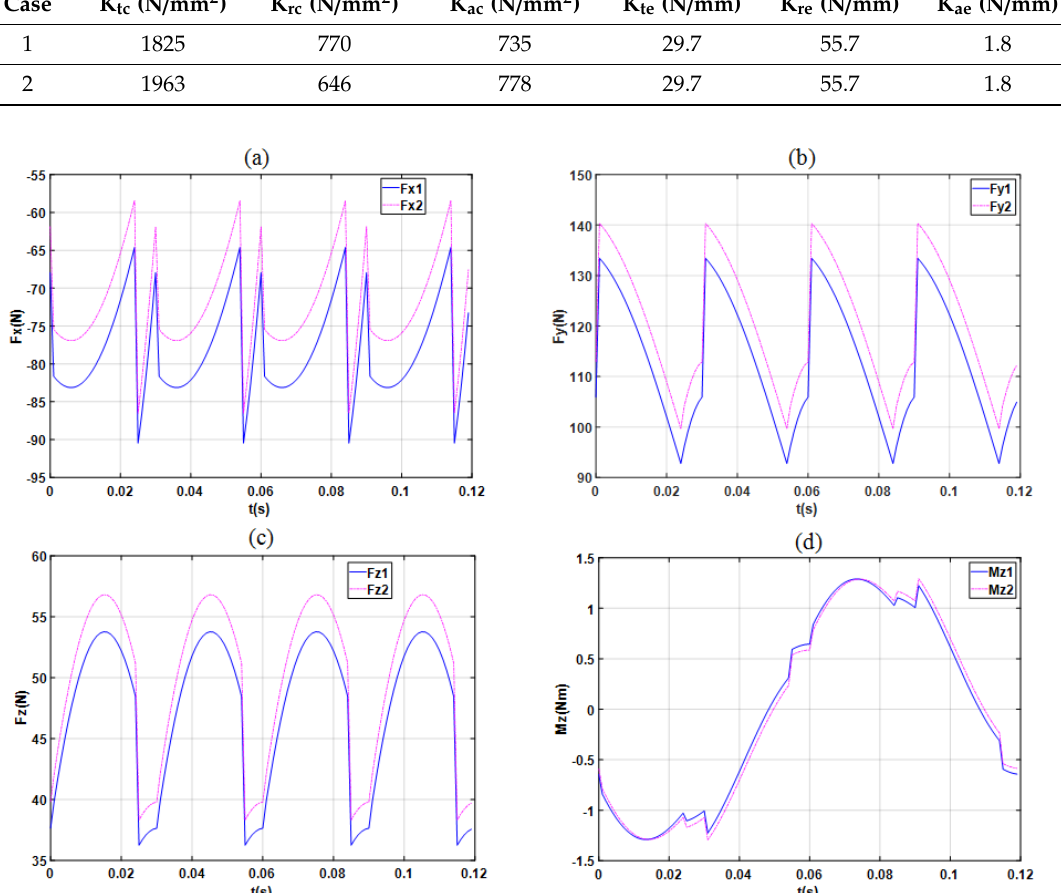
Table 5. Cutting force coefficients in milling.